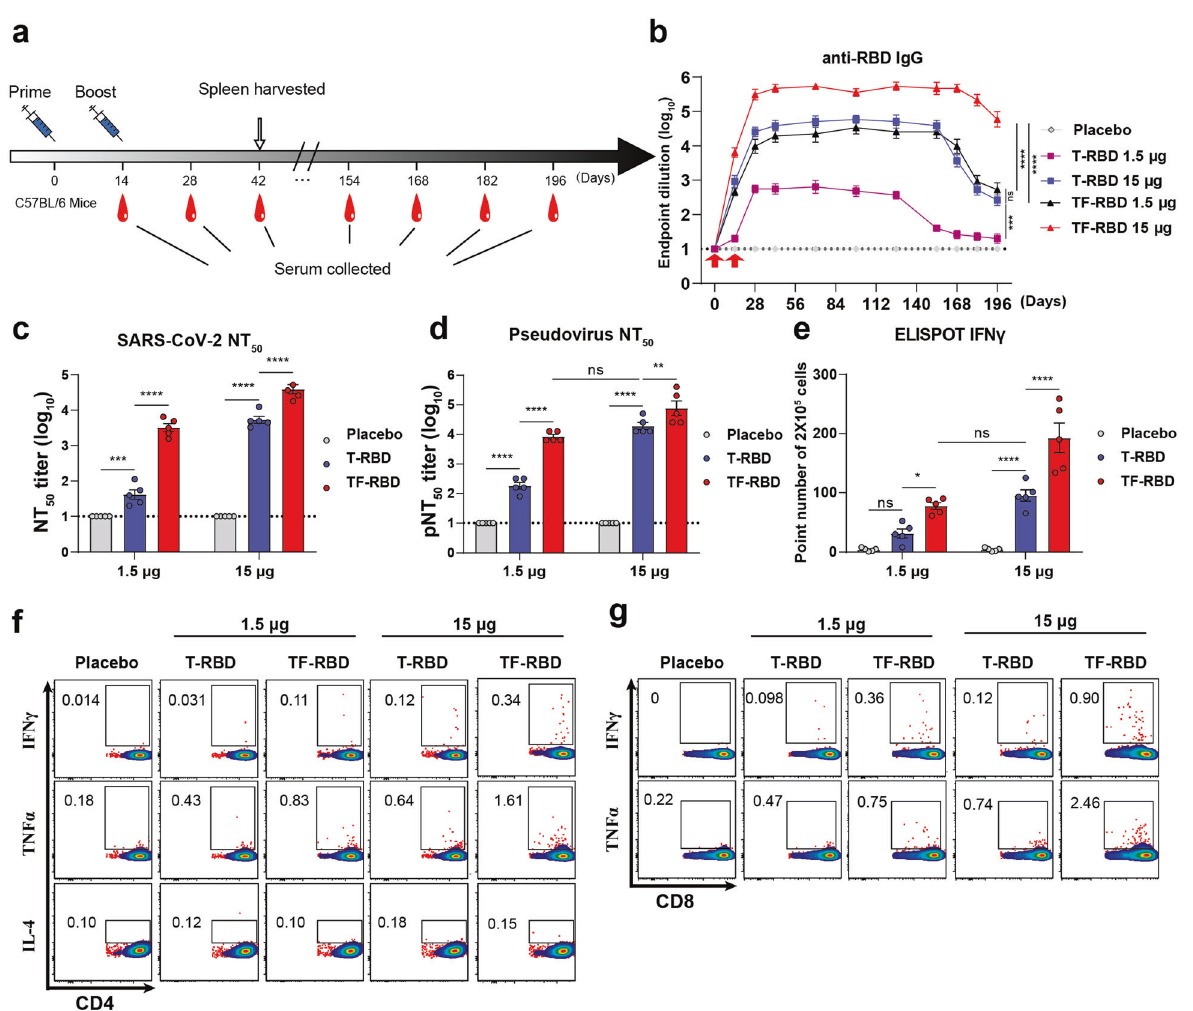
Fig. 3 Screening and evaluation of the T-RBD or TF-RBD mRNA vaccine candidates. a Immune procedures for evaluating the T-RBD or TF-RBD mRNA vaccine candidates. Groups of 6- to 8-week-old female naive C57BL/6 mice ( n = 10) were vaccinated with two doses (1.5 μ g, low; 15 μ g, high) of the mRNA LNPs at 2-week intervals. Blood collection and spleen extraction were performed at the time points shown after immunization. b ELISA revealed the RBD-speci fi c IgG titer of SARS-CoV-2. Serum samples were collected after each immunization event and used for the detection of IgG to evaluate the humoral response dynamics. A placebo formulation was given as the control. The red arrows indicate the immunization time point. c , d Neutralization assays of live SARS-CoV-2 in ( c ) and the SARS-CoV-2 pseudovirus in ( d ). e Protein- speci fi c T cell ELISPOT assay results. Spleen cells (2 × 10 5 ) were stimulated with the S RBD protein at a fi nal concentration of 10 μ g/mL. f , g Protein-speci fi c ICS assays. Spleens were harvested at 28 days after booster immunization, and the cells were stimulated with the S RBD protein at a fi nal concentration of 10 μ g/mL. The proportions of CD4 + protein-speci fi c T cells in ( f ) and CD8 + protein-speci fi c T cells in ( g ) are shown. The data are shown as the mean ± standard error of the mean (SEM). The dotted horizontal lines indicate the limits of quanti fi cation for ELISA and NT 50 titers. P values were determined by one-way ANOVA (ns, p > 0.05; * p < 0.05; ** p < 0.01; *** p < 0.001; **** p < 0.0001). See also Figures S1 –